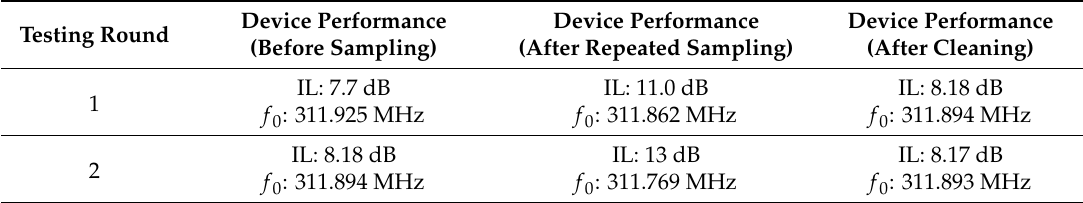
Table 1. Cleaning effect of a SAW sensing device during two testing